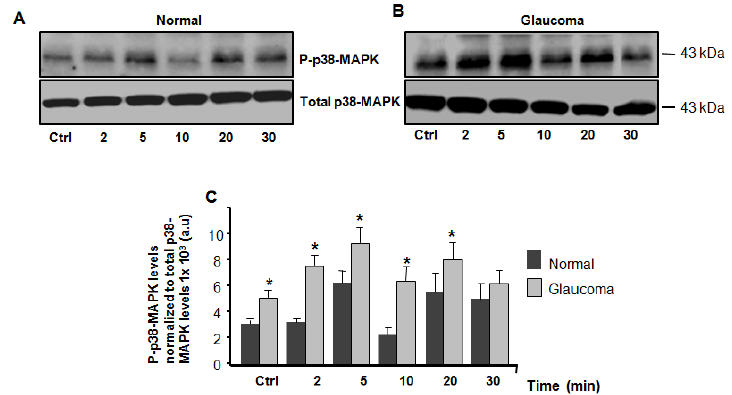
Figure 3. Western blot analysis of total and phospho- p 38-MAPK in normal and glaucoma LC cells. Equal amounts of cellular proteins (20 µg/lane), were separated on a 10% electrophoresis gel, transferred to a nitrocellulose membrane, and immunoblotted with a 1:1000 dilution of phospho and total antibodies specifically directed against p 38-MAPK, respectively. ( A ), (Top left panel), representative p 38-MAPK Western blot of LC cells exposed to isotonic physiological solution (for at least 15 min to obtain a stable baseline) and (B), (Top right panel), LC cells treated with hyposmotic solution at time-points of 2, 5, 10, 20, and 30 min. ( C ) Averages ± SE of at least three biological replicates comparing the expression and activity of p 38-MAPK in normal and glaucoma LC cells. * p < 0.05 was compared with time-matched controls (100%). Average data of expression and activity (phosphprylation) levels of p 38-MAPK were normalized to total p 38-MAPK levels. There was a significant increase in phosphorylated p 38-MAPK ( p − p 38-MAPK) protein expression at basal conditions (Ctrl) and p 38-MAPK activity (phosphorylation) at time-points of 2, 5, and 10 min, but no significant increase in p 38-MAPK activity was found at 20 and 30 min after exposure to hyposmotic